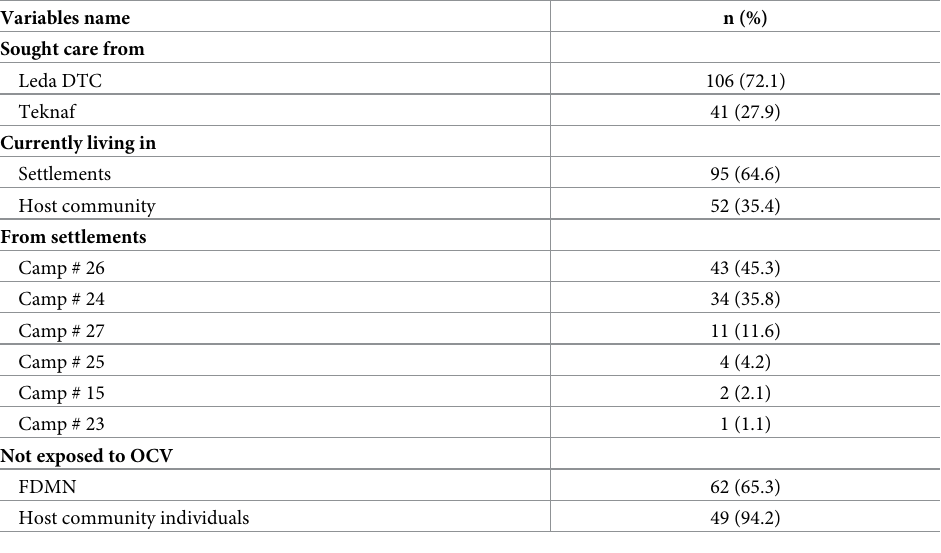
Table 1. Distribution of characteristics of culture-confirmed cholera patients (n = 147) in Leda and Teknaf DTCs in Cox’s Bazar settlements, September-December